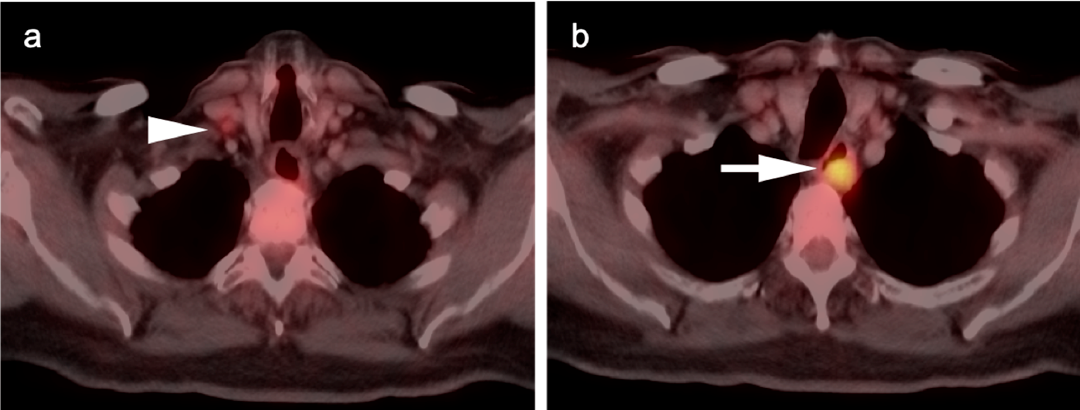
4 of 35 Figure 3. Esophageal cancer pre- and post-treatment. ( a ) Pre-treatment axial fused FDG PET-CT image shows a circumferential hypermetabolic esophageal tumor (white arrow); ( b , c ) Axial ( b ) and coronal fused FDG PET-CT images five weeks post-neoadjuvant CRT demonstrate residual soft tis- sue thickening and metabolic activity (white arrow), although improved from pre-treatment. This would require biopsy to distinguish residual viable tumor from post-treatment inflammatory change. In addition, there is increased metabolic activity along the left border of the liver (white arrowhead) likely due to the liver being within the radiation field. Many false-negative FDG PET-CT scans are also seen with esophageal cancer, due to superficial or small tumors and highly mucinous neoplasms. Depth of penetration and length of the tumor cannot be accurately assessed by PET or CT. For these determinations, esophageal endoscopic ultrasound (EUS) is preferable. In addition, for initial staging of esophageal cancer, both CT and FDG PET-CT are limited in detection of regional nodal metastases in the immediate vicinity of the primary tumor, with a range in sensitivity and specificity for CT and FDG PET-CT of 41–60% and 77–89%, and a range in sensitivity and specificity for CT or FDG PET-CT of 43–70% and 76–95% [9]. For detection of distant me- tastases, FDG PET-CT offers a clear advantage over CT [9]. Patterns of initial nodal spread [10] depend upon the location of the primary tumor. Cervical esophageal cancers typically spread first to paraoesophageal cervical or upper